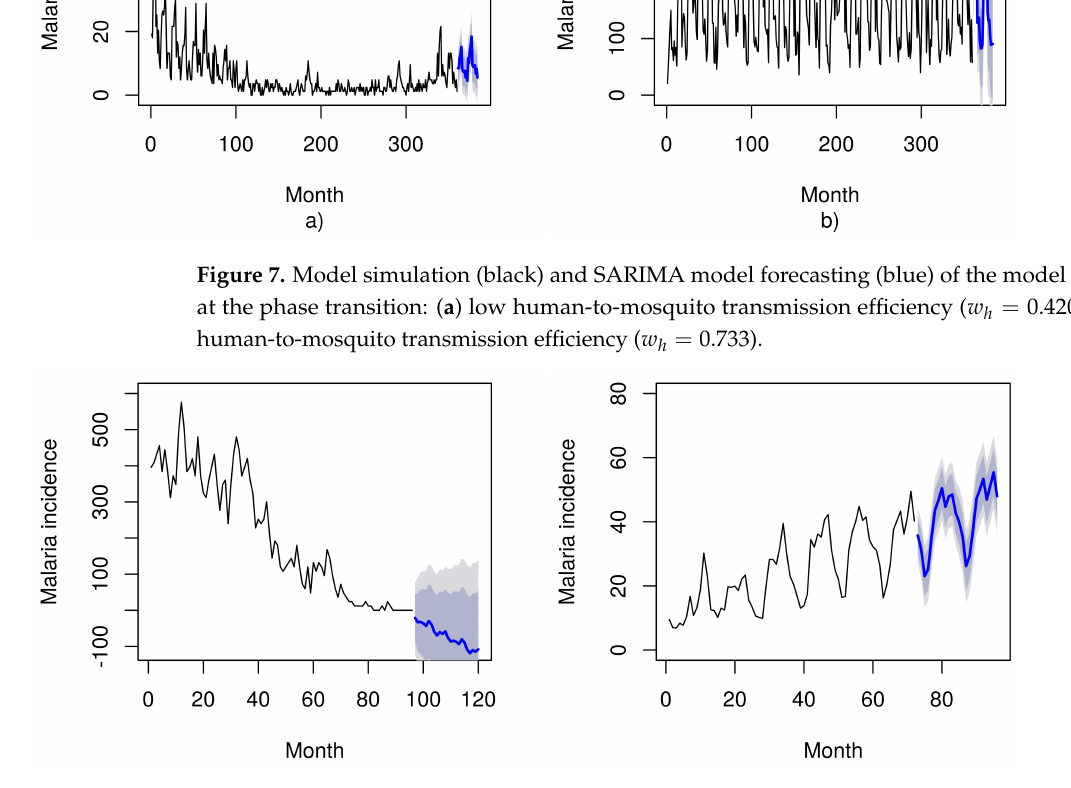
Figure 8. ( Left ) Empirical time series (black) and SARIMA model forecasting (blue) from Okech, 2008 [27] empirical time series, along with declining malaria incidence. The SARIMA forecast predicts rapid disease elimination evolving towards negative values. ( Right ) Empirical time series (black) and SARIMA model forecasting (blue) from the Landoh, 2012 [25] empirical time series, along with a steady increase in malaria incidence. The SARIMA forecast predicts a trend of progressive disease spreading.